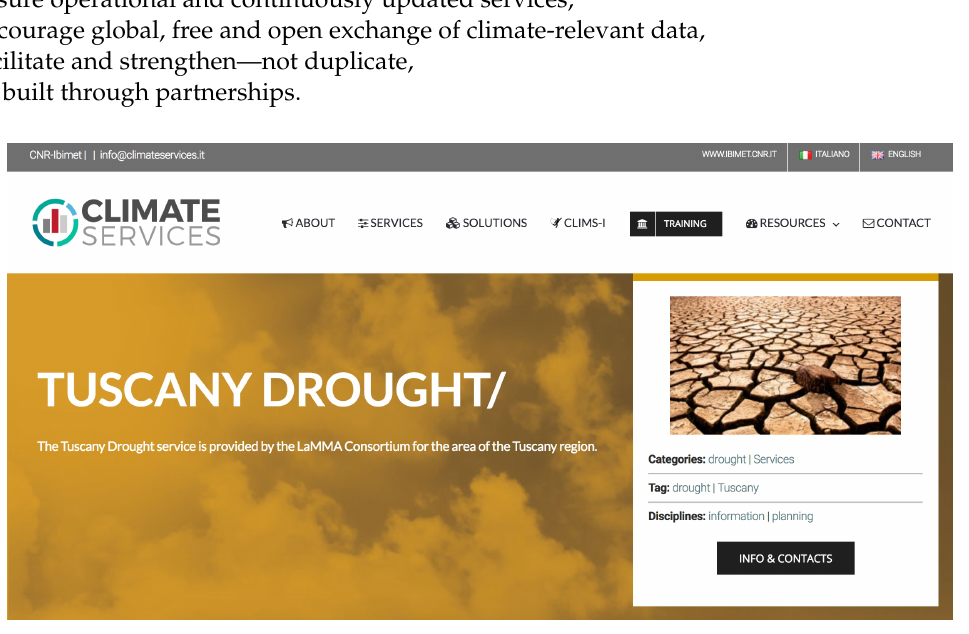
Figure 13. Climate Services of IBIMET-CNR: web page dedicated to the drought